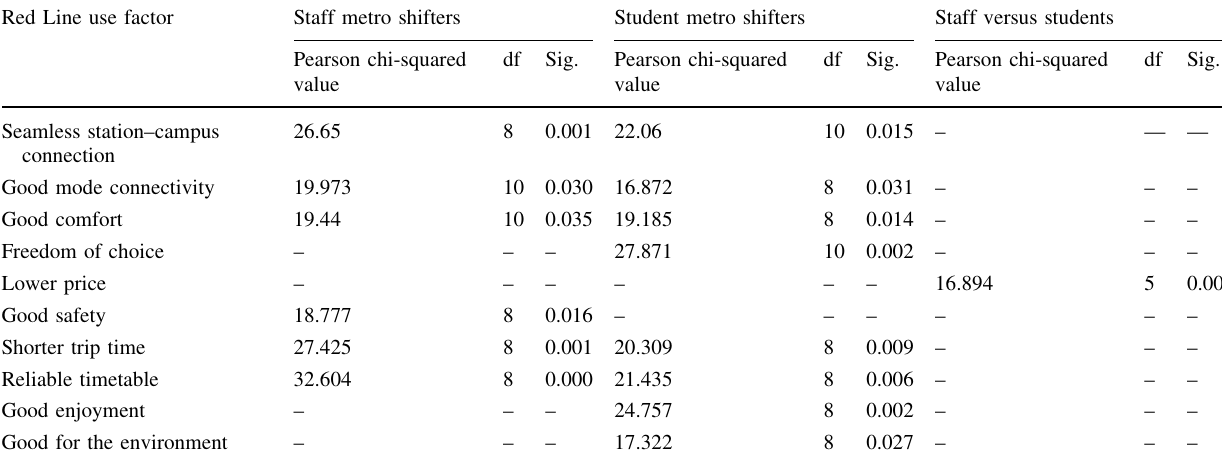
Table 5 Statistically significant results of chi-squared tests for the 10 factors Red Line use factor